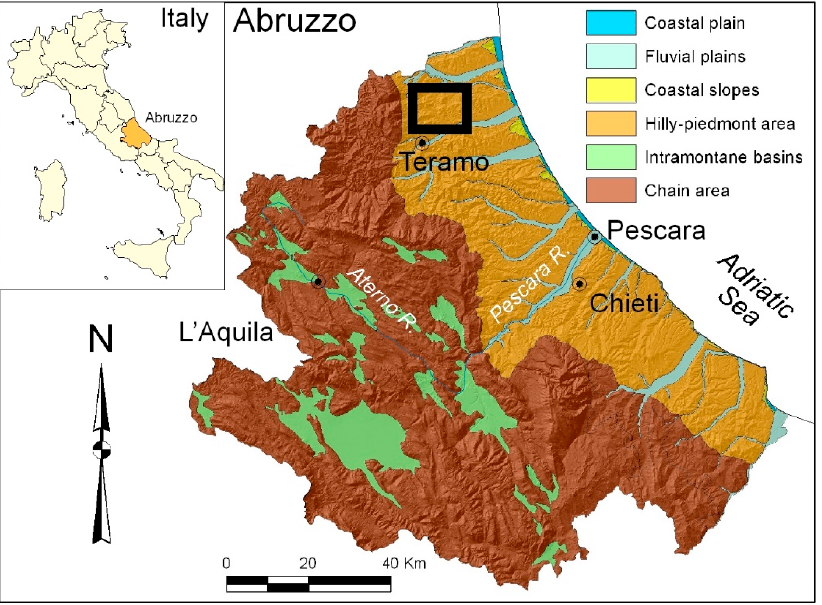
Figure 1. Location map and main physiographic domains of the Abruzzo region (the study areas are in the black box).